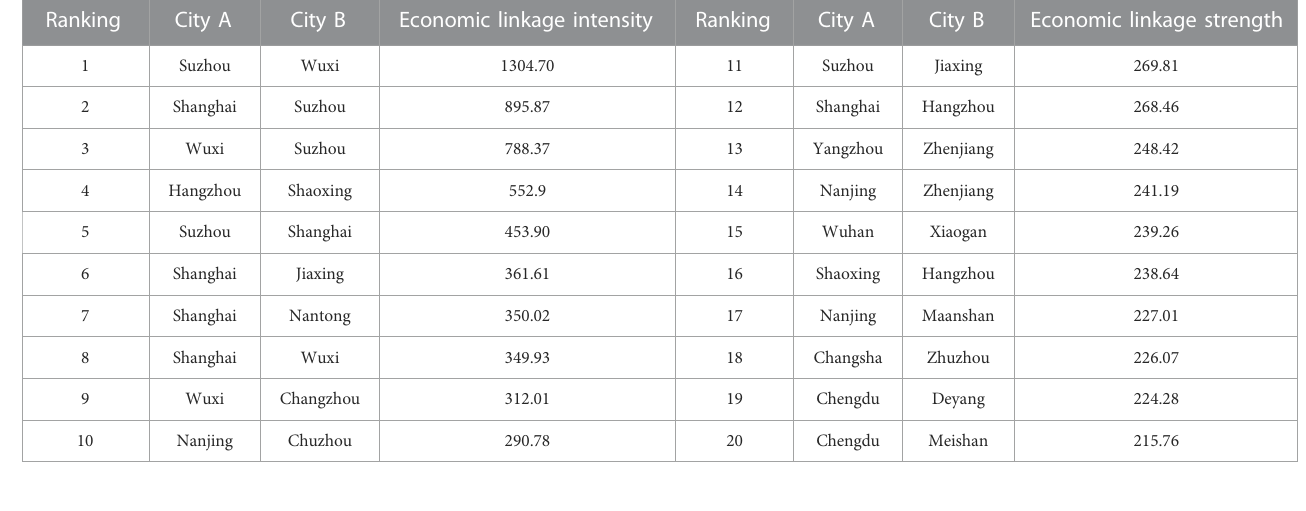
TABLE 1 Top 20 city pairs in terms of economic linkage intensity in 2020.